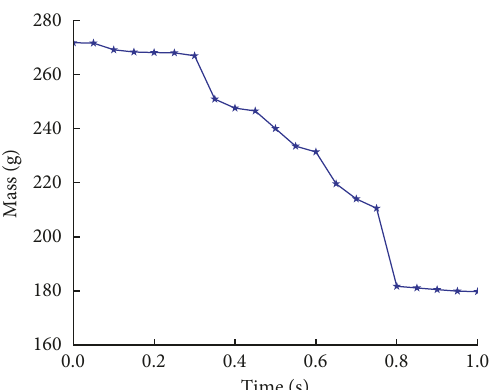
Figure 7: Characteristic particle trajectory.